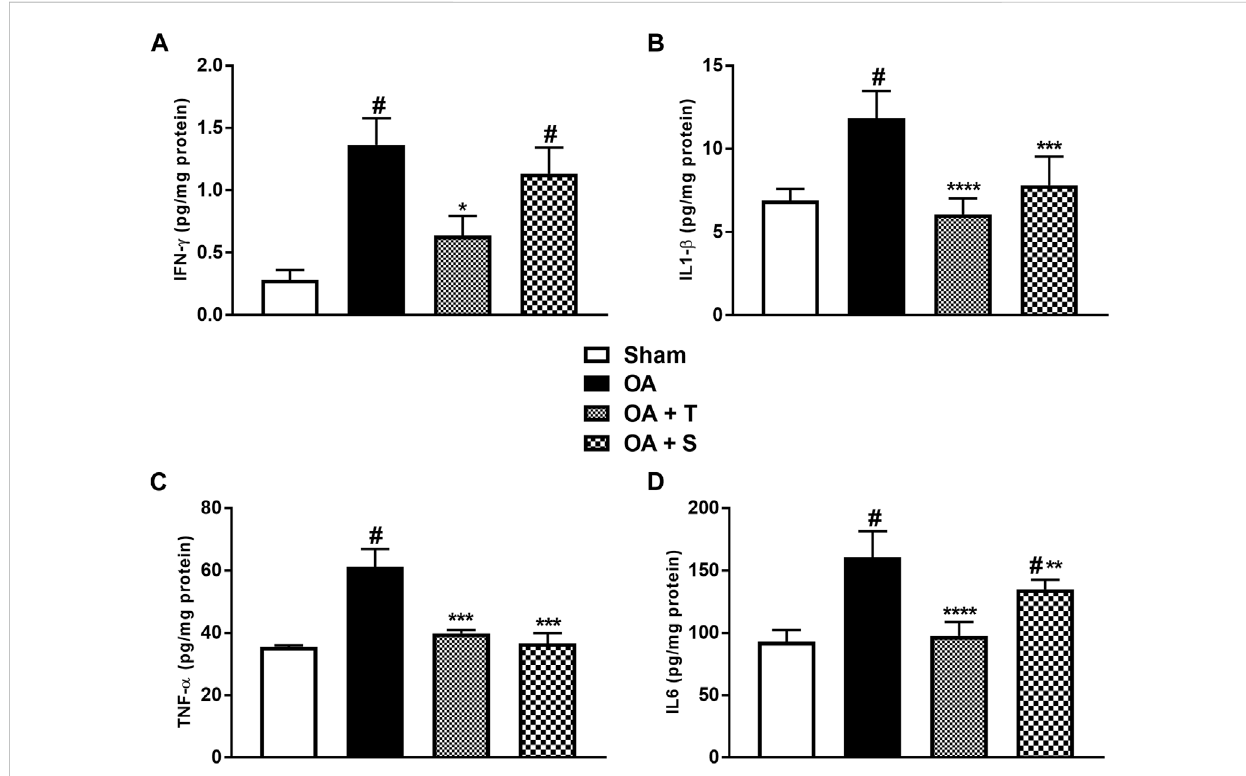
FIGURE 5 Pro-in fl ammatory cytokines. (A) IFN- ʎ ; (B) IL1- β ; (C) TNF- α ; (D) IL6. Abbreviations: IL, interleukin; IFN, interferon; OA, osteoarthritis; TNF, tumor necrosisfactor. Dataarepresentedas mean±SEM,inwhich: # p < 0.05vs.ShamGroup;* p < 0.05vs.OAGroup;** p < 0.01 vs.OAGroup;*** p < 0.001 vs. OA Group; **** p < 0.0001 vs. OA Group; (One-way ANOVA followed by Tukey post-hoc